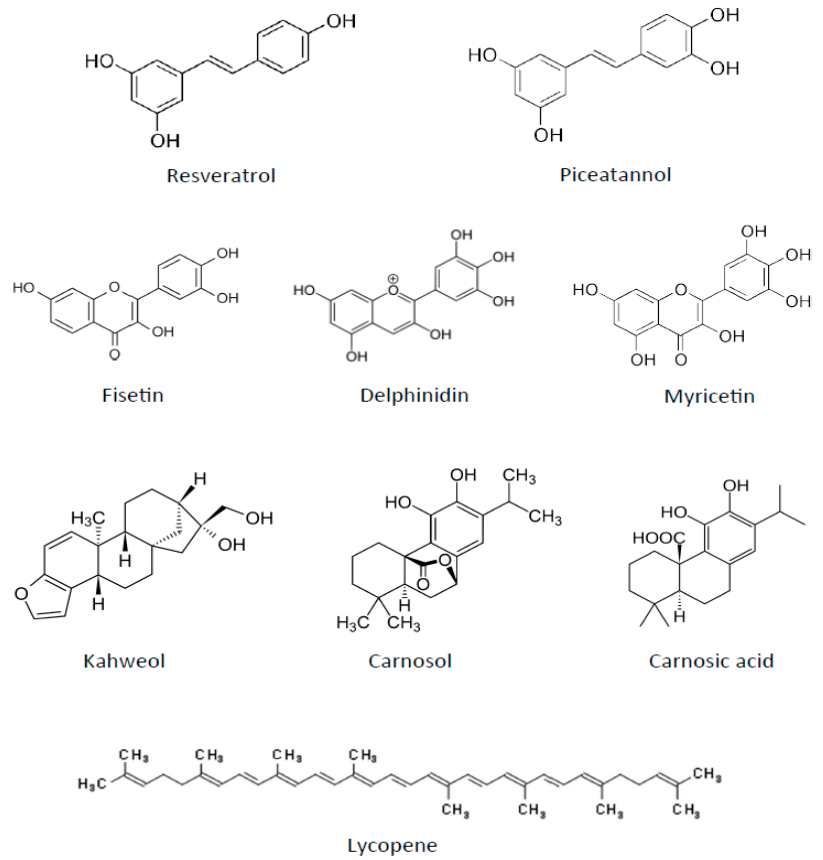
Figure 3. Chemical structures of other antiangiogenic compounds present in the Mediterranean diet (MD) components.